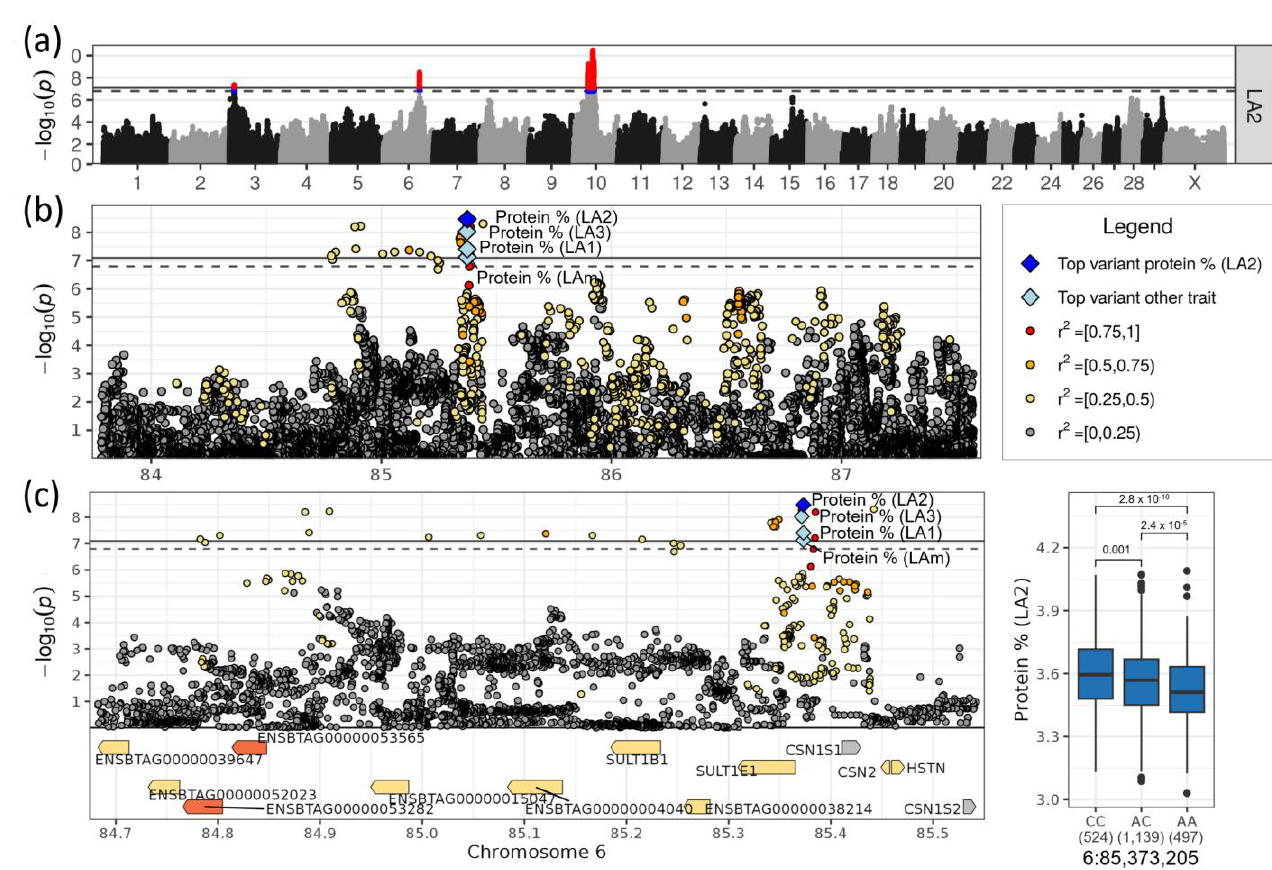
Figure 5. ( a ) Manhattan plot for milk protein content in LA2. Suggestive ( p < 0.1, dashed line) and significant ( p < 0.05, solid line) associations are highlighted in blue and red, respectively. ( b ) Regional association plot for the QTL on chromosome 6. ( c ) Zoomed regional association plot including genes and effect plot for top SNP for protein content in LA2. Genes containing variant(s) with low, moderate or high impact are colored green, yellow and orange, respectively, and are otherwise grey.